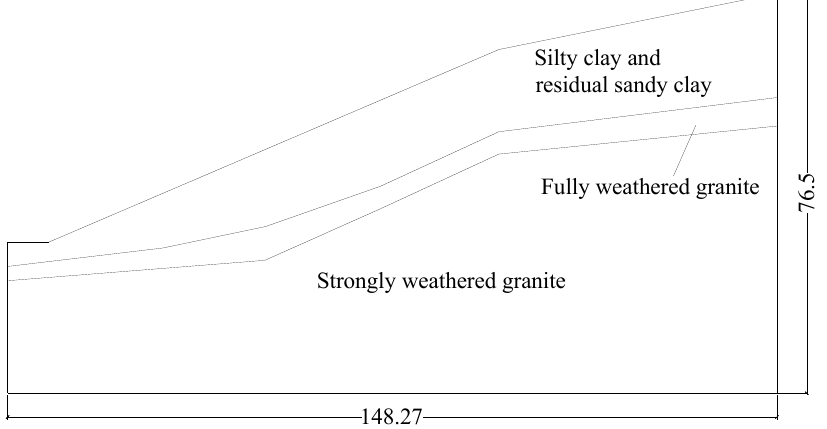
Figure 2. Engineering geological profile.